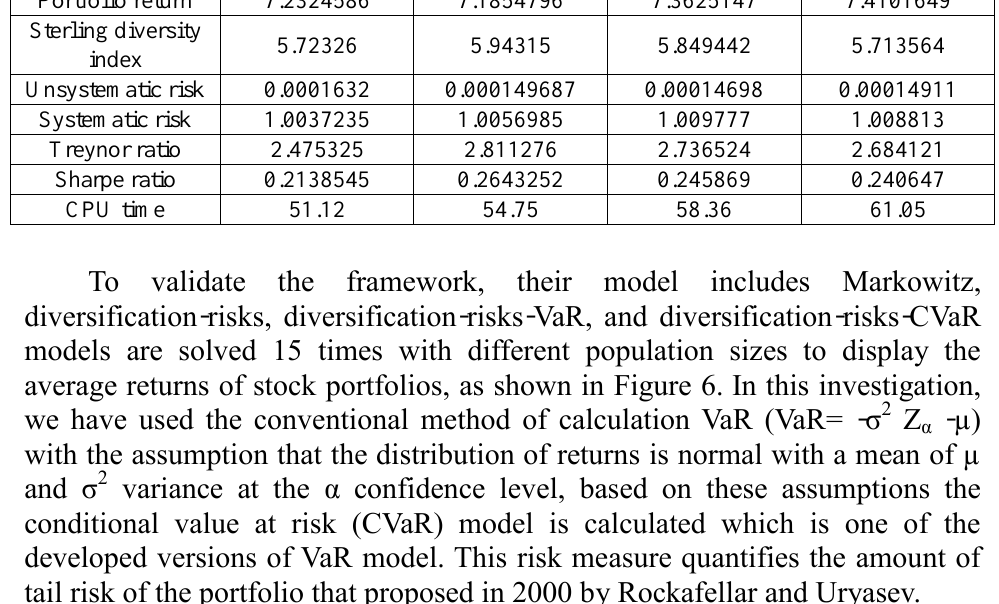
Table 9. Compression of the proposed model with Markowitz and diversification-risks models using LP-metric based GA Models Criteria Diversification- Diversification- Diversification- Markowitz risks risks-VaR